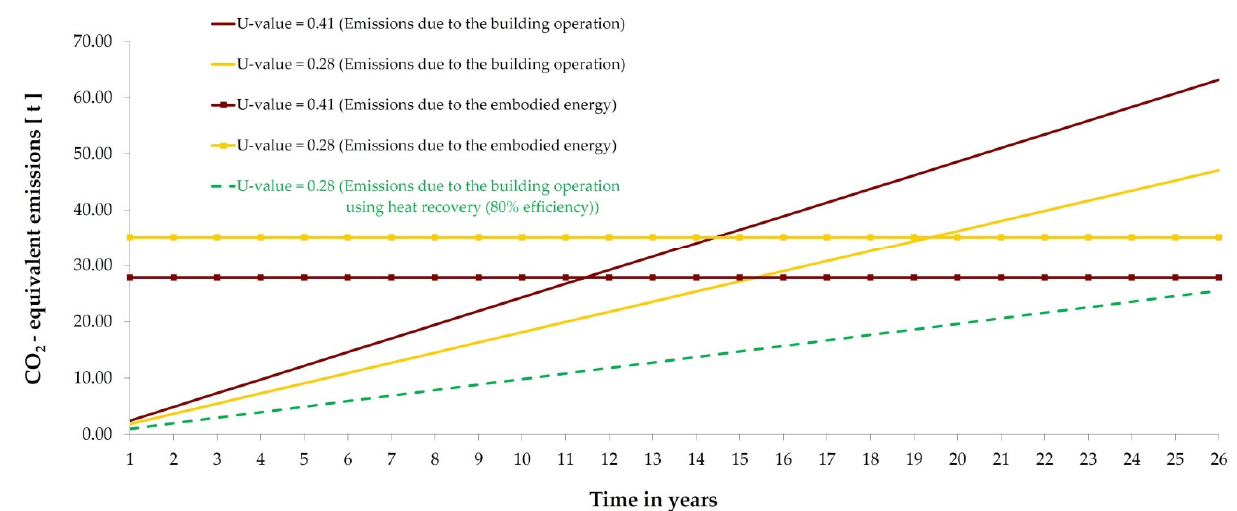
Figure 4. Time needed to achieve the “break-even point” equalizing the CO 2 -equivalent emissions due to the embodied energy with CO 2 emissions due to the building operation in dependence on the mean U -values (W/(m 2 .K)) of a massive house. The CO 2 -equivalent emissions due to the embodied energy are expressed by constant lines and the CO 2 -equivalent emissions due to the building’s operation are represented by ascending lines.